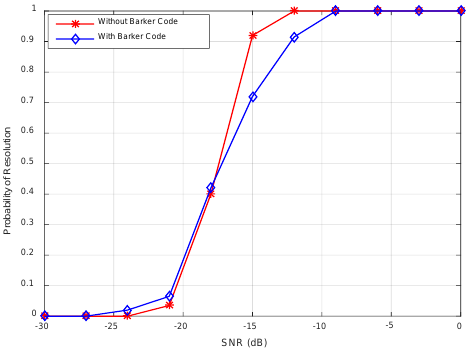
Figure 16. Resolution probability against SNRs.